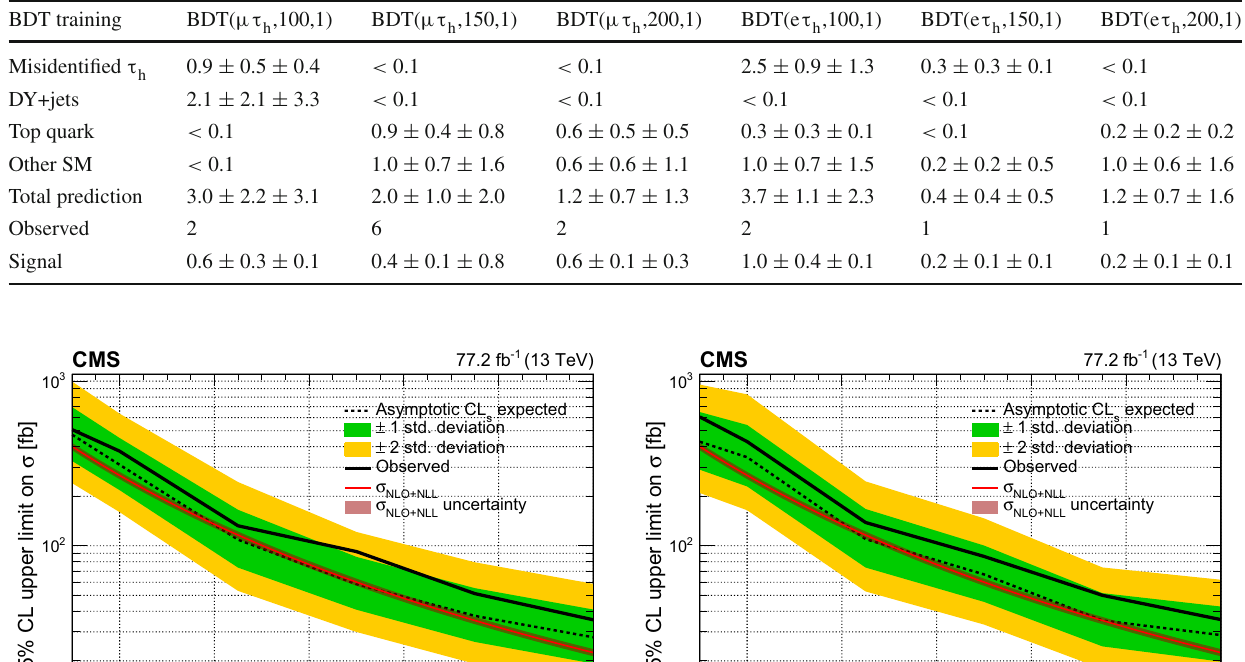
The uncertainty in the integrated luminosity is taken into account in all background estimates for which we do not extract normalization scale factors in dedicated data